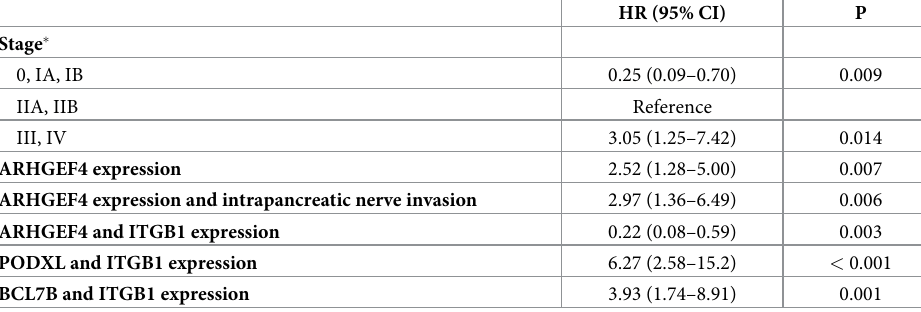
Table 6. Multivariate analysis using the Cox proportional hazards regression